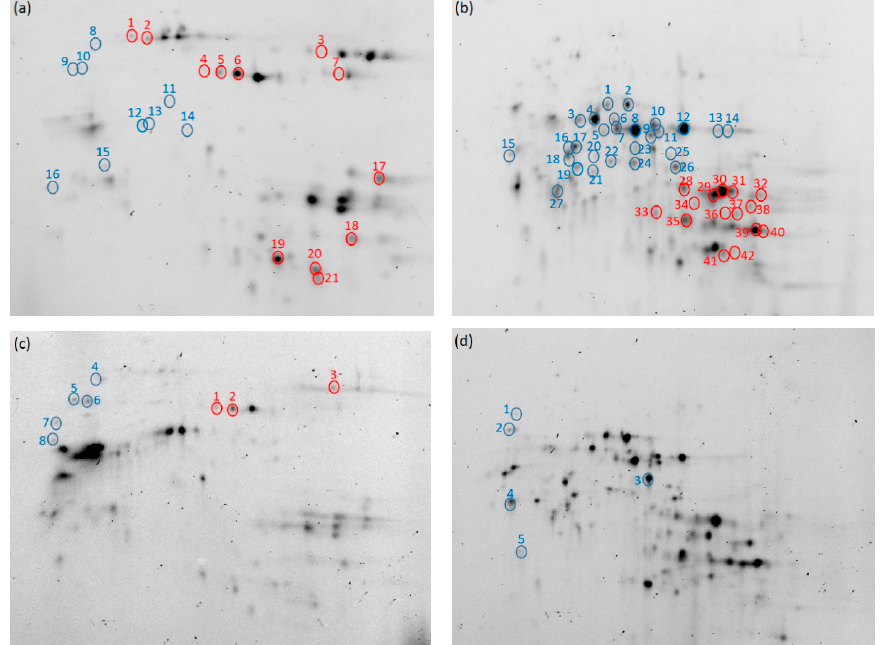
Figure 6. Electrophoretic images of the protein aggregates ( a , c ) and monomeric proteins ( b , d ) in high-protein flour (HF) ( a , b ) and low-protein flour (LF) ( c , d ) extracted with 30% 1-propanol. Blue circles show proteins with decreased intensities after buildup ( n = 4, p < 0.05), and red circles show proteins with increased intensities after buildup ( n = 4, p < 0.05). The numbers correspond to those in Tables 1–4.